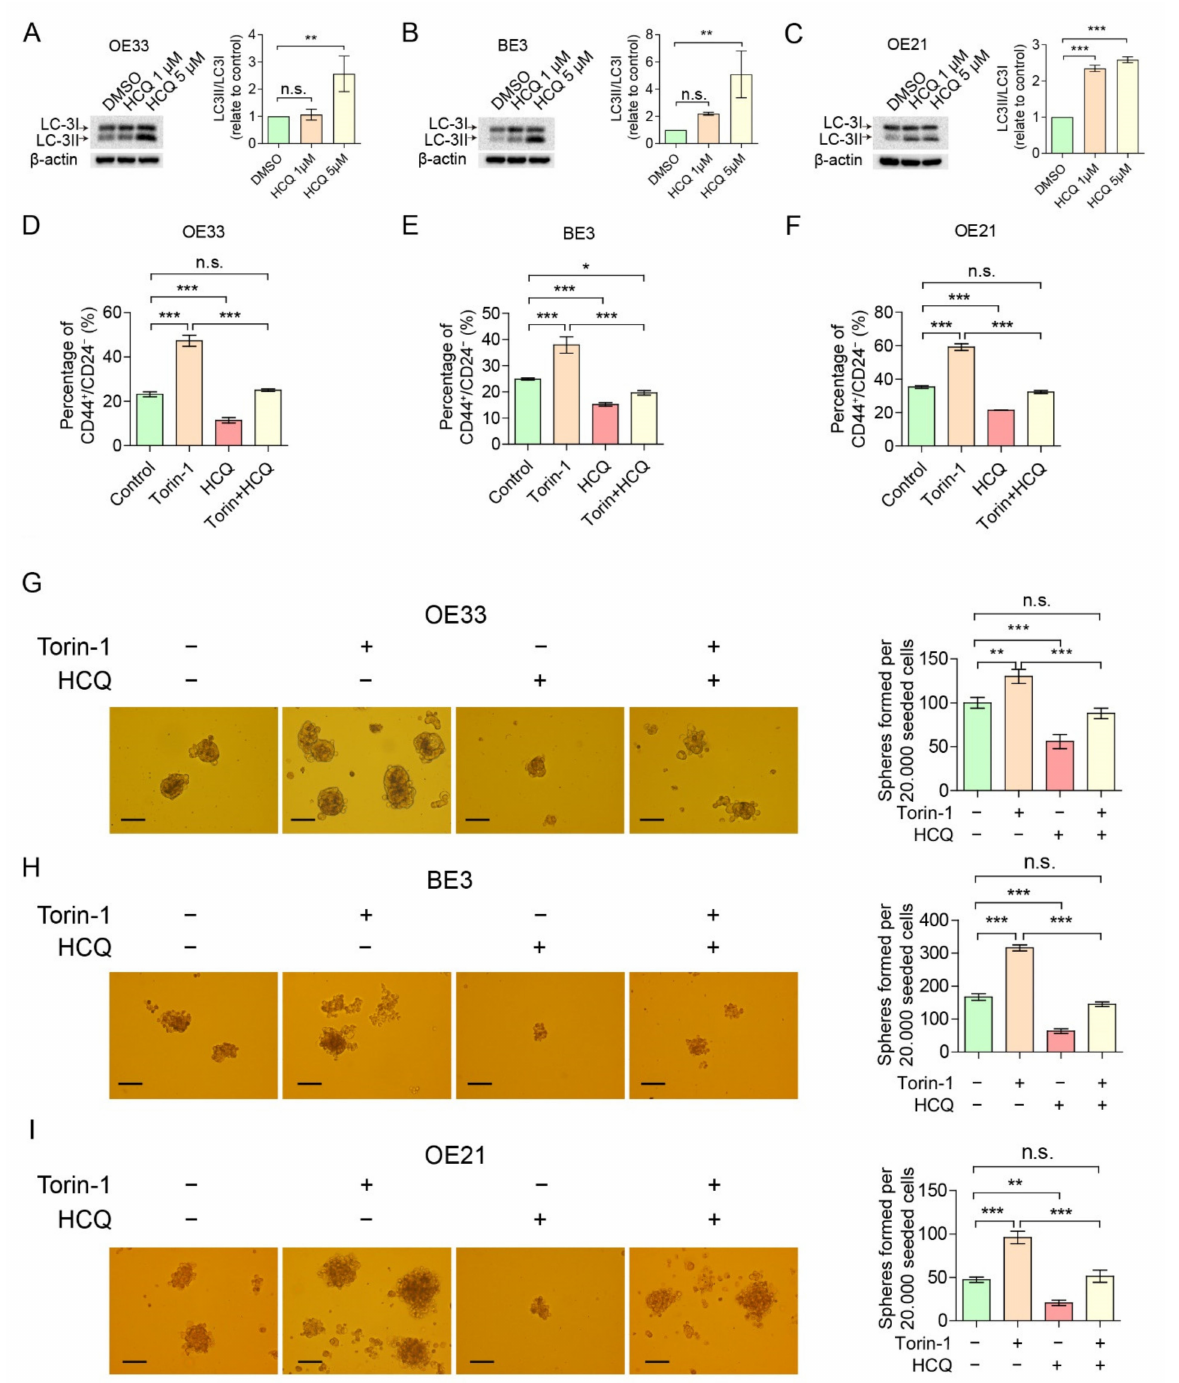
Figure 4. mTOR inhibited cancer stemness via autophgy. ( A – C ) Cells treated with HCQ (OE33 at 5 µ M, BE3 and OE21 at 1 µ M and 5 µ M) for 48 h had an increased ratio of LC-3II/LC-3I compared to controls. ( D – F ) Flow cytometry analysis of CD44 + /CD24 − in cells treated with a combination of HCQ and Torin-1 or alone (OE33, HCQ at 5 µ M and Torin-1 at 4 nM; BE3 and OE21, HCQ at 1 µ M and Torin-1 at 8 nM). ( G – I ) Sphere formations of cells treated with a combination of HCQ and Torin-1 or alone (OE33, HCQ at 5 µ M and Torin-1 at 4 nM; BE3 and OE21, HCQ at 1 µ M and Torin-1 at 8 nM). Scale bar = 100 µ m. Error bars indicate SD. n.s., not statistically significant; * p < 0.05, ** p < 0.01 and *** p < 0.001 by two-way ANOVA followed by a Tukey–Kramer post hoc test. n.s.: not statistically significant. The uncropped blots are shown in Supplementary